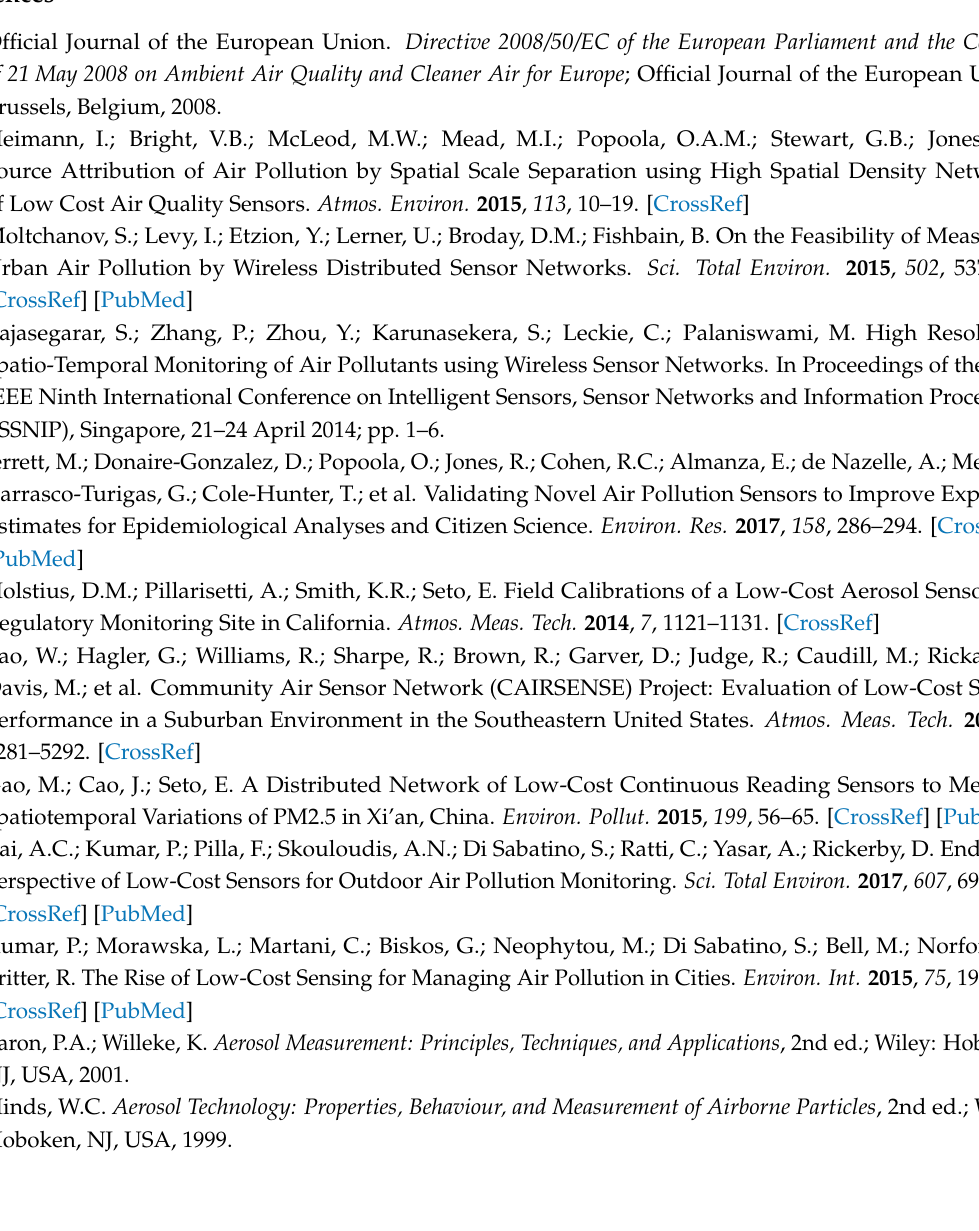
Figure S1: A Schematic of the sensor configuration, Figure S2: The PAS unit, Figure S3: A Schematic of the PAS, Figure S4: Meteorological conditions during the field